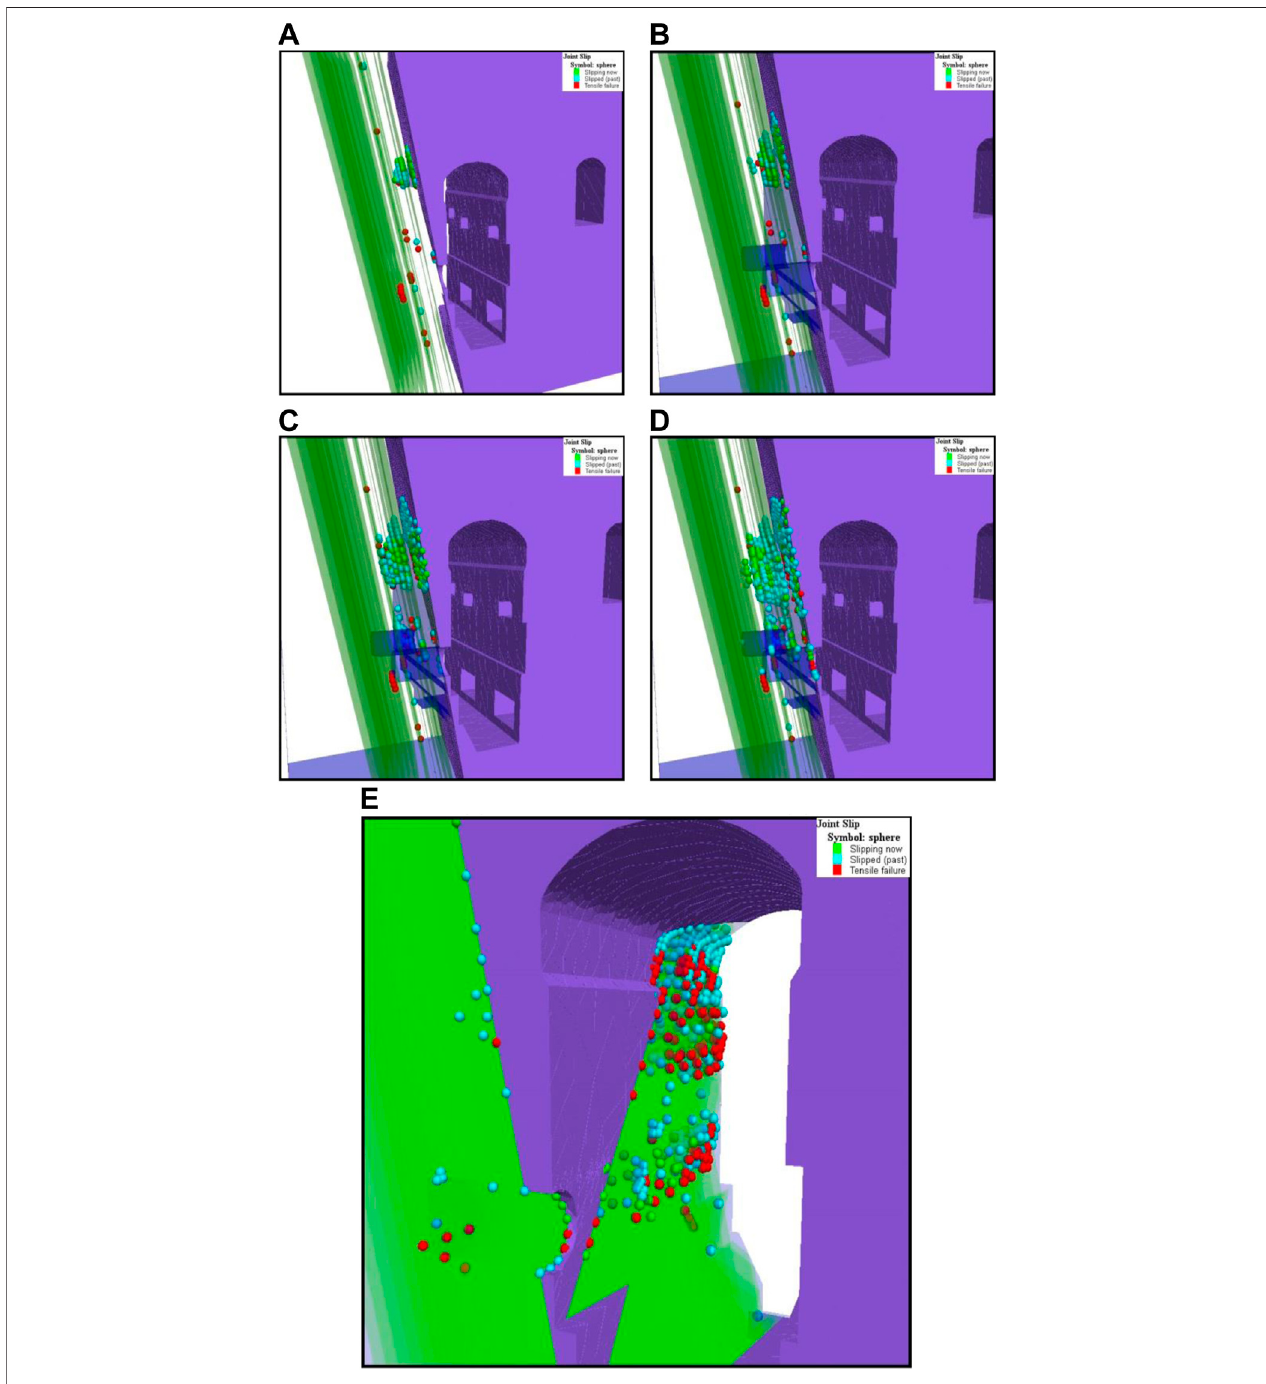
FIGURE9| Failure characteristics ofsurrounding rocks onupstreamsidewall after sequential excavations under unsupportedcondition. (A) step1, (B) step 2, (C) step 3, (D) step 4, (E) front view after step 4. Red ball-tensile failure, blue ball-shear failure in previous steps, green ball-current shear failure.